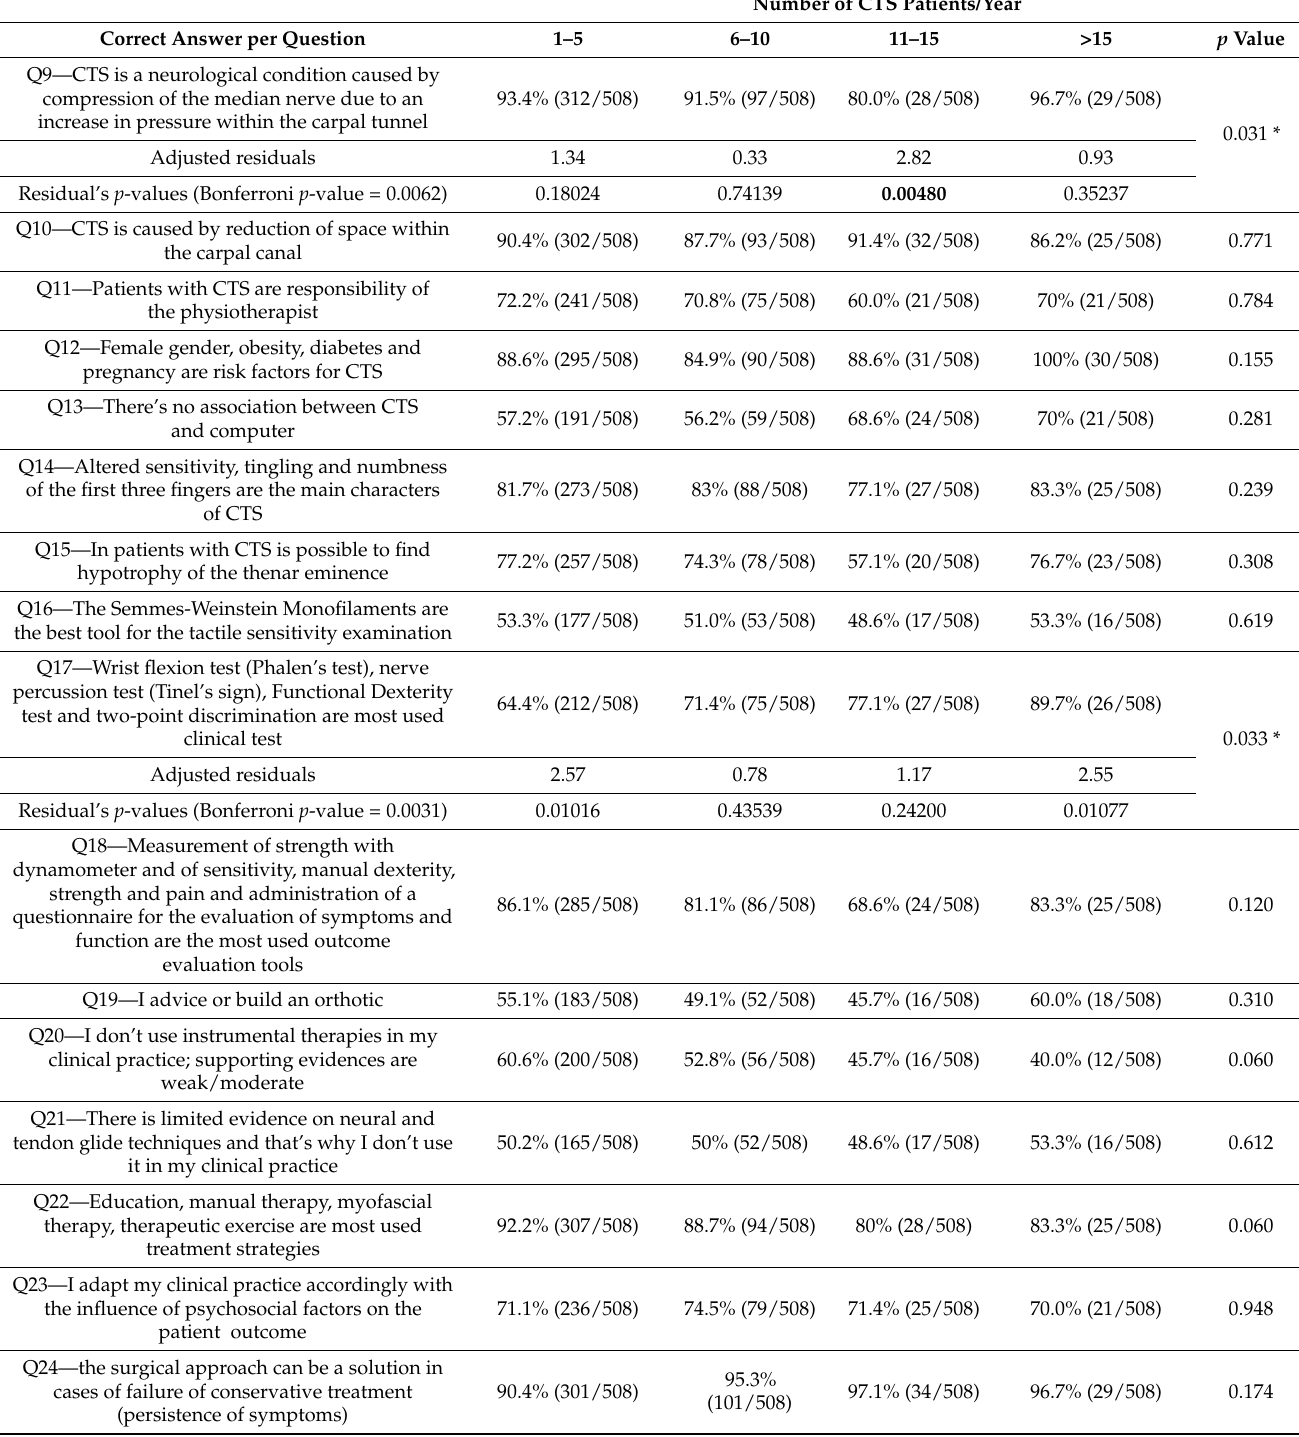
Table 4. Inferences between correct answers and number of cases treated each year by